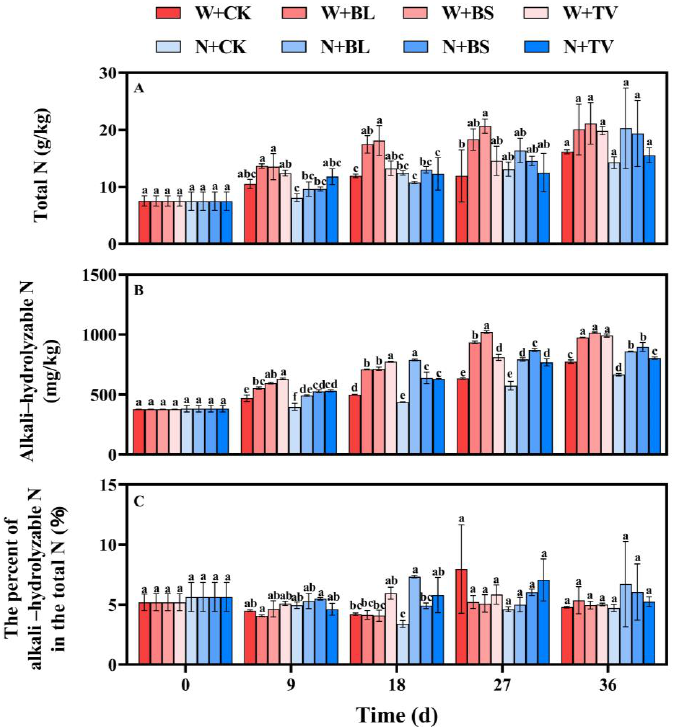
Figure 5. Changes in nitrogen concentrations in the treatments. Means ± SEs with different letters in each parameter indicate significant statistical differences ( p < 0.05). ( A ) Total N, ( B ) Alkali-hydrolyzable N, ( C ) The percentage of alkali-hydrolyzable N in the total N.